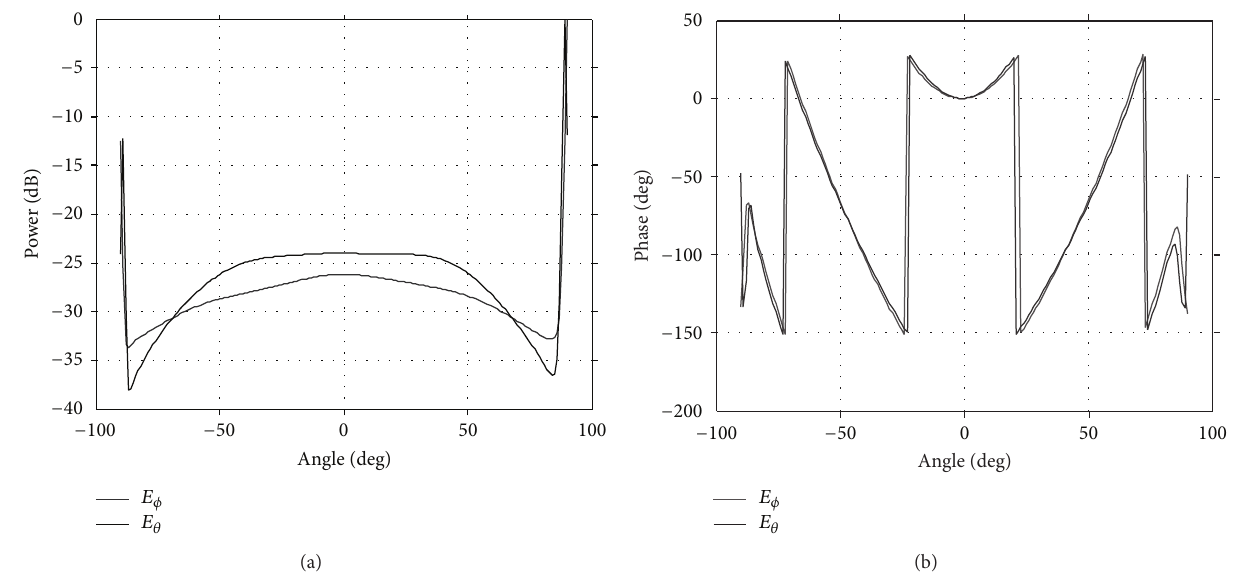
Figure 21: (a) Near field radiation pattern of conical horn at a distance 𝑟 = 1𝜆 (3.2 cm). (b) Near field phase pattern of conical horn at a distance 𝑟 = 1𝜆 (3.2